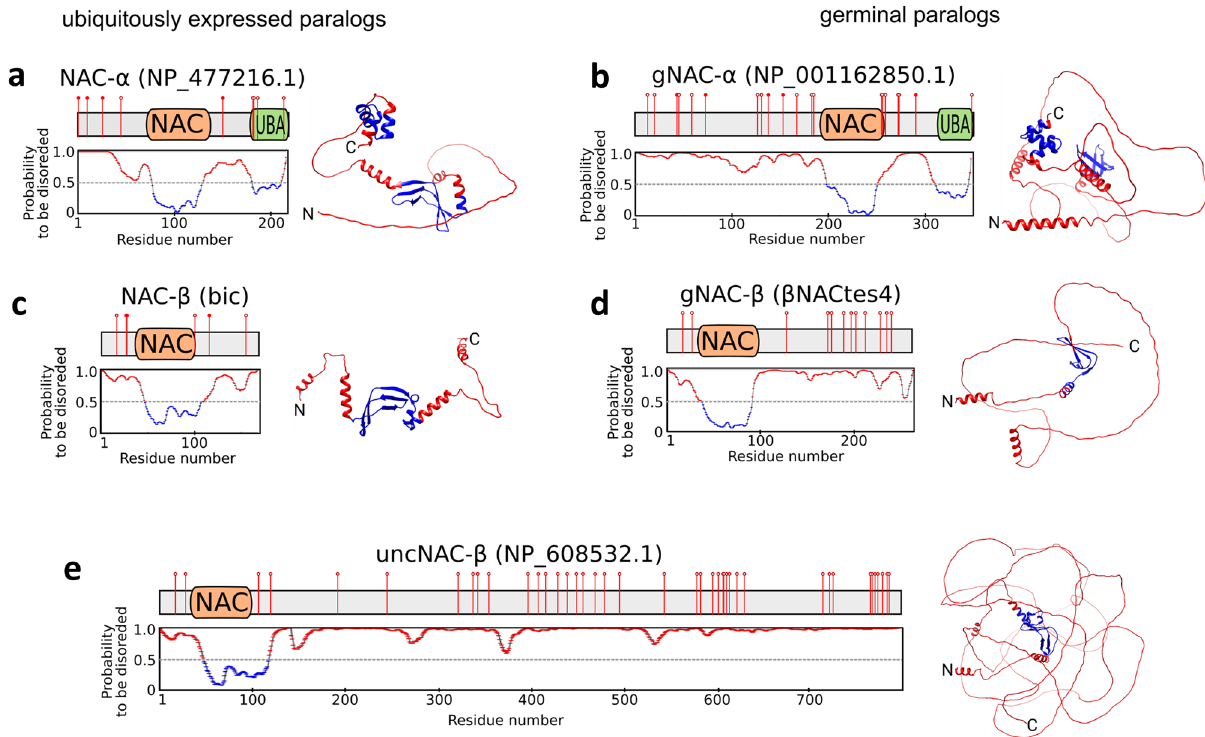
Figure 2. Order–disorder profiles of NAC containing polypeptides with corresponding predicted AlphaFold structures. AlphaFold 27,28 red and blue colors mark the degree of uncertainty of predicted structure, reflecting the degree of disorderness. The ELM predicted phosphosites are marked by red circle lollipops, sites predicted by ELM 33 and confirmed using iProtein DB 34 are marked by filled red circles. ( a ) NAC-α, ( b ) gNAC-α, ( c ) NAC- β, ( d ) gNAC-β, ( e )